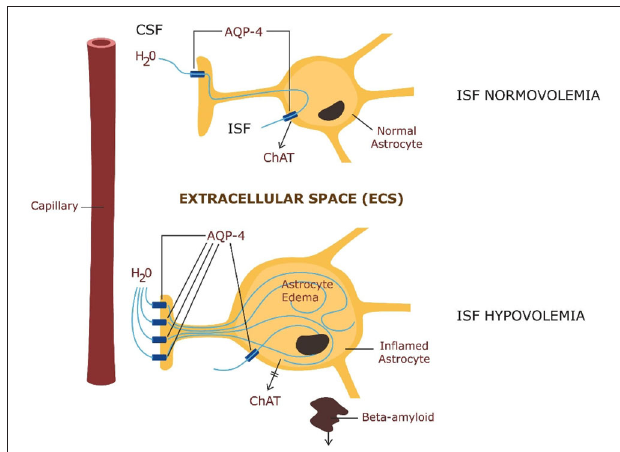
FIGURE 2 | ABOVE: Astrocytic physiology—intra-parenchymal CSF exchange with the interstitial fluid (ISF) via AQP-4 channels and ChAT secretion . BELOW: Pathology—astrocytic edema: up-regulation of AQP-4 in astrocytic end-feet with impairment of ChAT secretion and beta amyloid